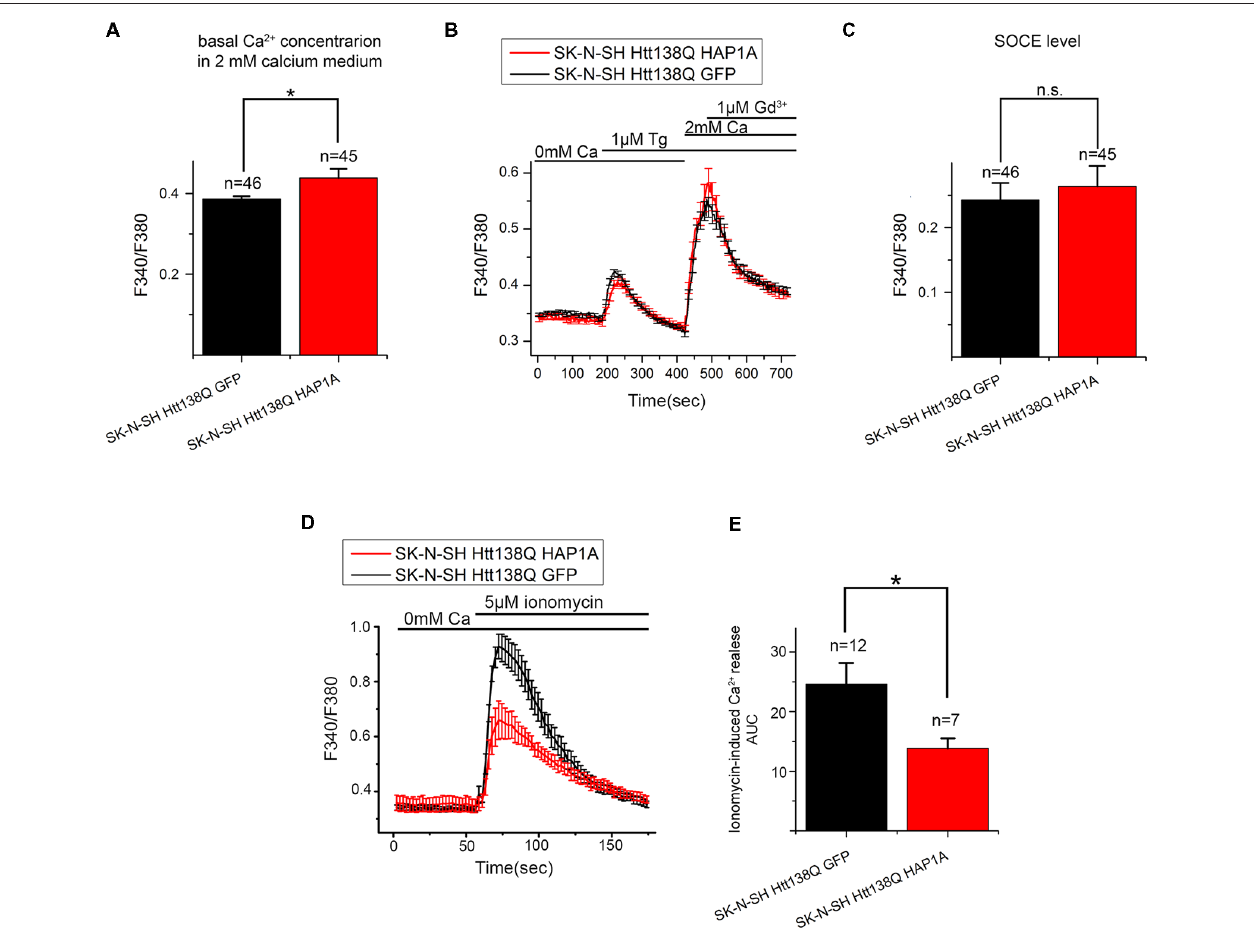
FIGURE 9 | Level of SOCE in SK-N-SH Htt138Q HAP1A. (A) Average basal Ca 2 + levels in the medium that contained 2 mM CaCl 2 in SK-N-SH Htt138Q cotransfected with GFP (black bar) or HAP1A (red bar), plotted as mean ± SEM. ∗ p < 0.05, significant difference in basal calcium level. The number of experiments is shown above the bars. (B) Responses of cytosolic calcium levels to 1 µ M thapsigargin application in SK-N-SH Htt138Q cotransfected with GFP (black curve) or HAP1A (red curve). The number of experiments is shown in (C) above the bars. (C) Average amplitudes of thapsigargin-induced SOCE levels in SK-N-SH Htt138Q cotransfected with GFP (black bar) or HAP1A (red bar), plotted as mean ± SEM. ∗ p < 0.05, significant difference in current amplitude. (D) Responses of cytosolic calcium levels to the application of 5 µ M ionomycin in SK-N-SH Htt138Q cotransfected with GFP (black curve) or HAP1A (red curve). The number of experiments is shown in (E) above the bars. (E) Average amplitudes of ionomycin-induced calcium release levels in SK-N-SH Htt138Q cotransfected with GFP (black bar) or HAP1A (red bar), plotted as mean ± SEM. ∗ p < 0.05, significant difference in current amplitude. ns, not